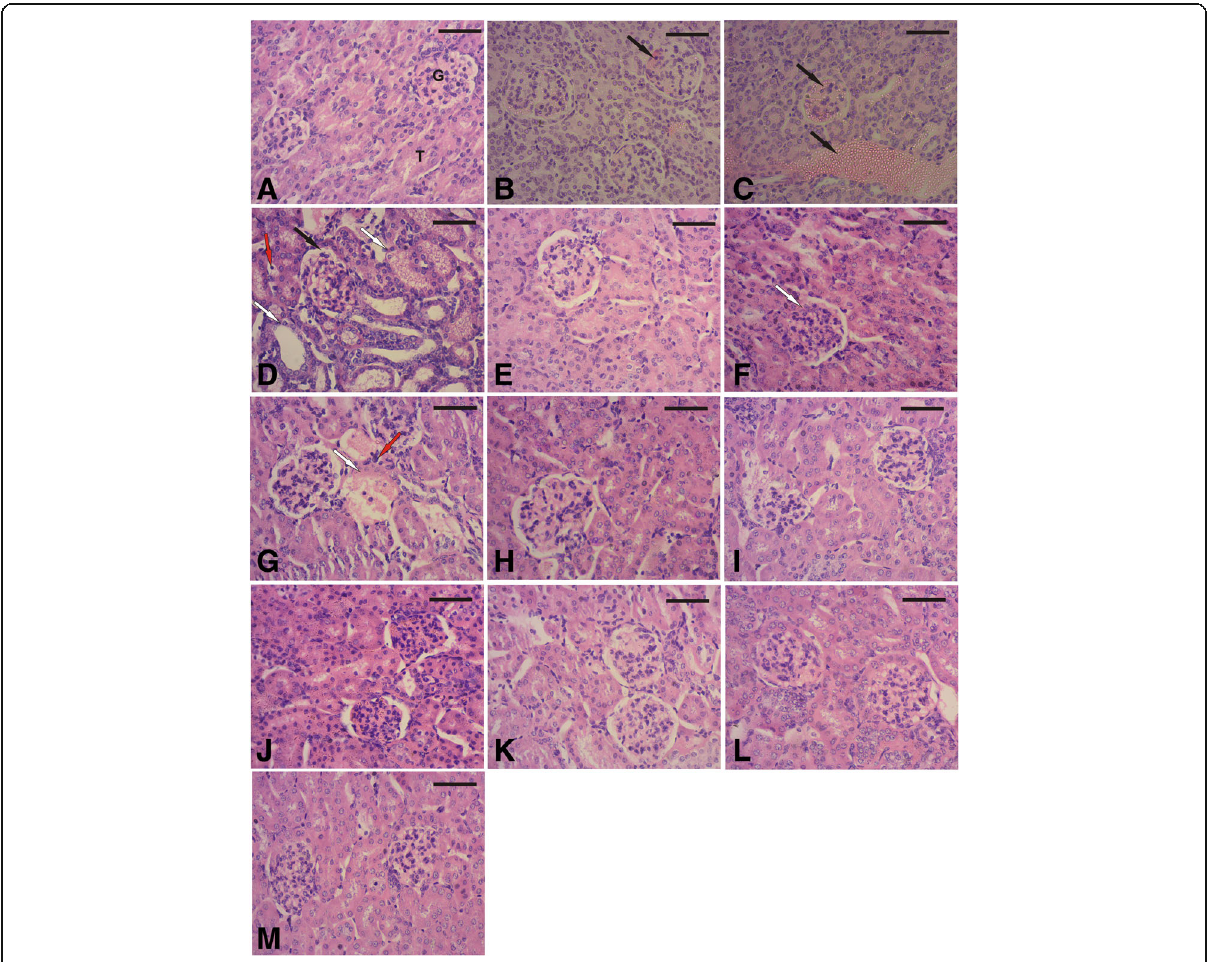
Fig. 4 Photomicrographs of kidney sections of the control group ( a ). Acrylamide-administrated groups at 30 days ( b ) and 45 days ( c ). At 60 days of administration ( d ) showing squamation of kidney tubules (white arrow) and inflammatory cell infiltration (red arrow). Chips feeding group at 30, 45, and 60 days ( e – g ) showed damage of the kidney tubules. BV-treated group ( h ) and BPF-treated group ( i ) at 60 days showed a similarity with the control group. Acrylamide-administrated groups treated with either BV ( j ) or BPF ( k ) showing improvement of the damage tubules as compared to acrylamide-administrated groups. Chips feeding groups treated with BV ( l ) or BPF ( m ) showing improvement at the histological level as compared to chips feeding groups. H&E stain scale bar 10 μ